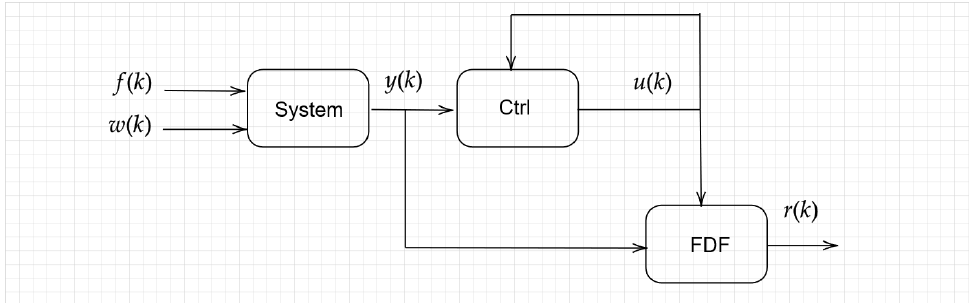
Figure 1. Graphic description of the FD scheme used to design the gain-scheduled fault detection